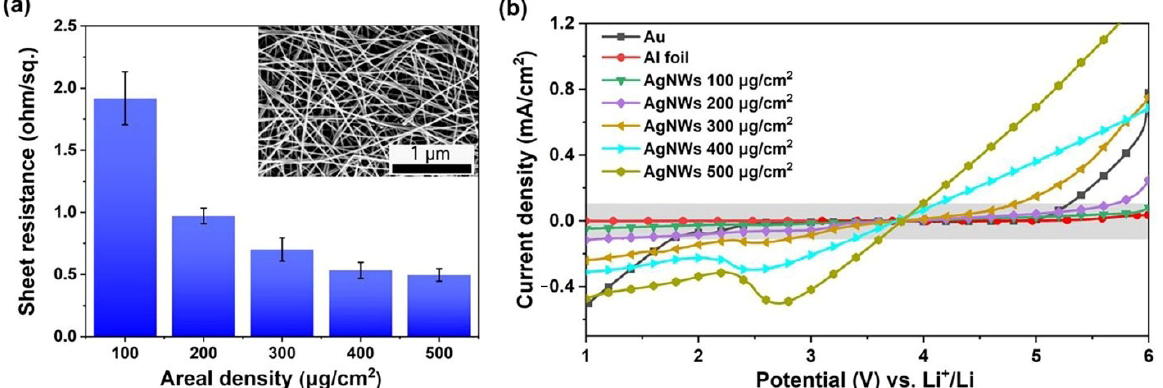
Figure 1. Sheet resistance and electrochemical stability window of AgNW films. ( a ) Sheet resistance of AgNW films with various areal densities. The inset in ( a ) shows one typical SEM image of the AgNW film of 200 μ g/cm 2 . ( b ) Linear sweep voltammetry (LSV) curves of various conductive materials under a scan rate of 10 mV/s in 2 m LiTFSI–94%PEG–6%H 2 O electrolyte.